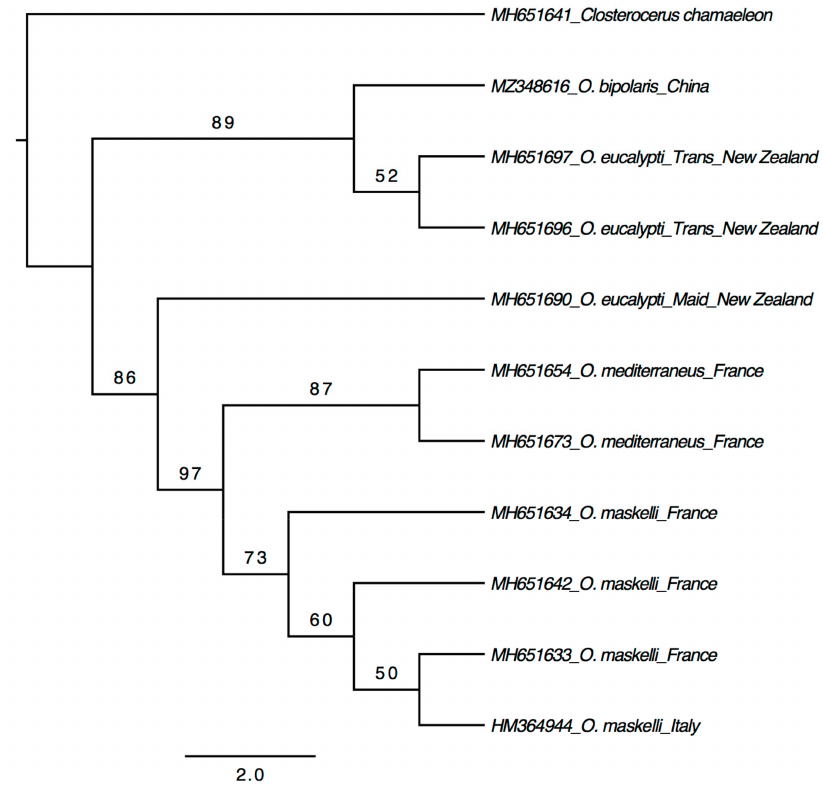
Figure 3. Maximum likelihood tree based on 28S